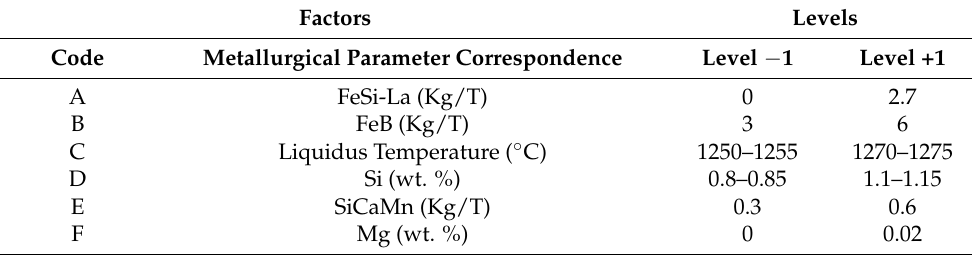
Table 2. Factors and levels analysed in the Design of Experiments.